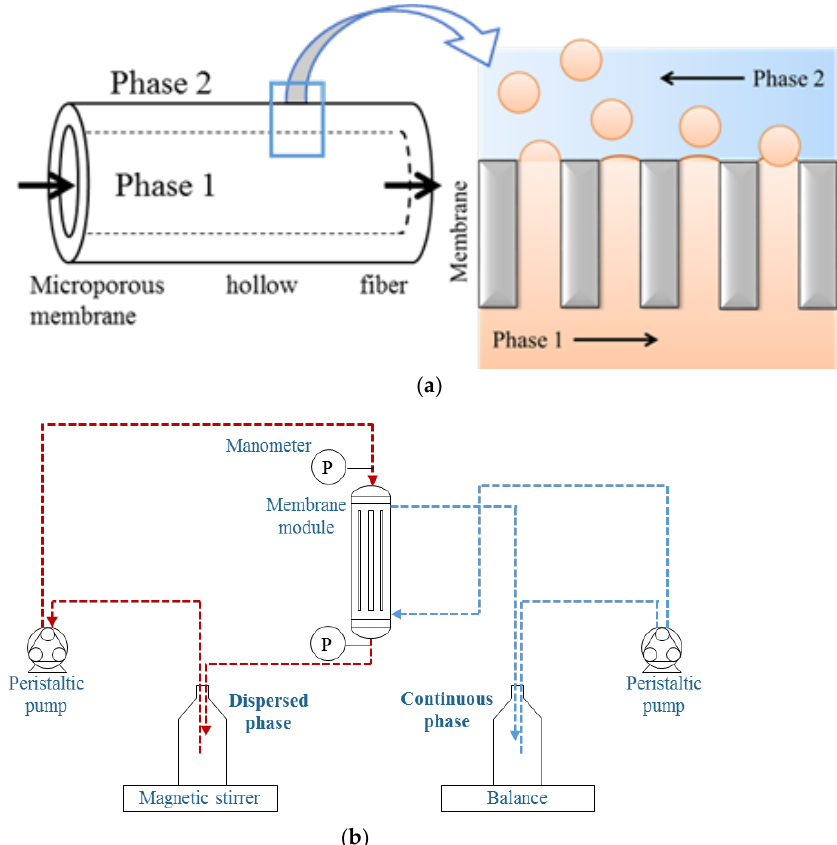
Figure 1. ( a ) Schematic representation of membrane emulsification process; and ( b ) membrane emulsification setup.